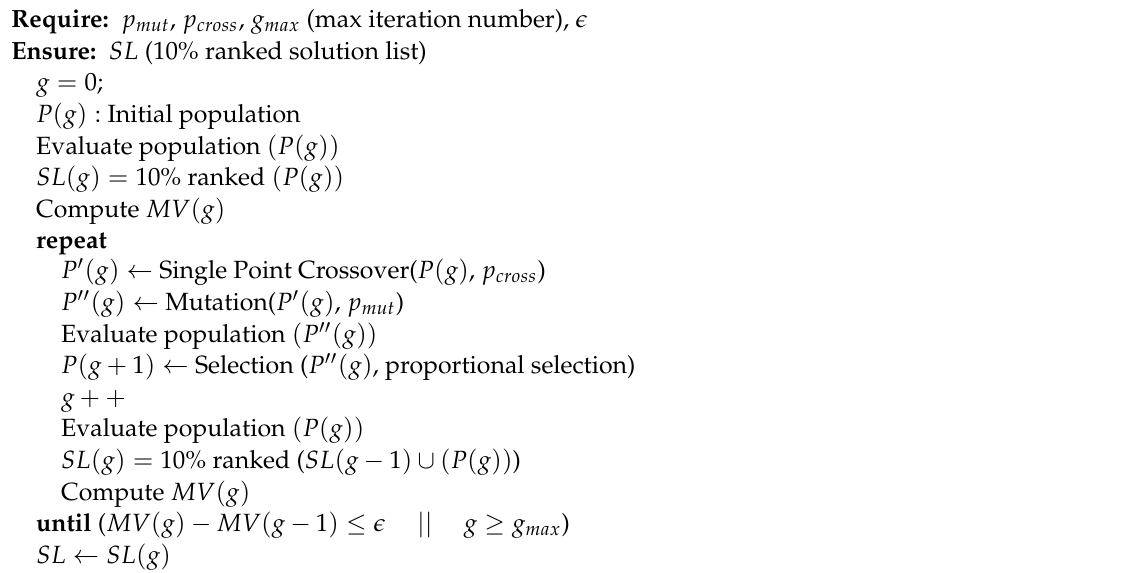
Algorithm 2 GA for the fair technology distribution problem.